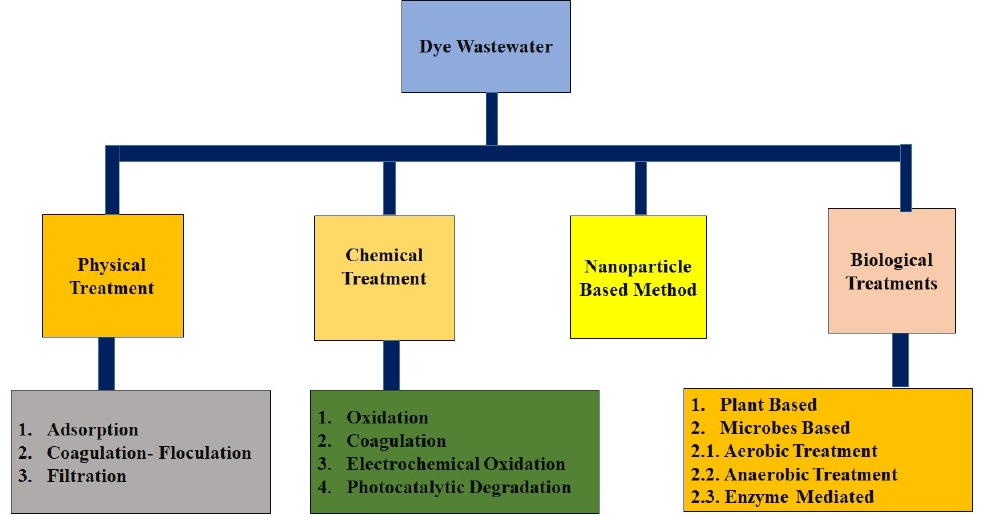
Figure 2. Treatment strategies of dye-containing wastewater.